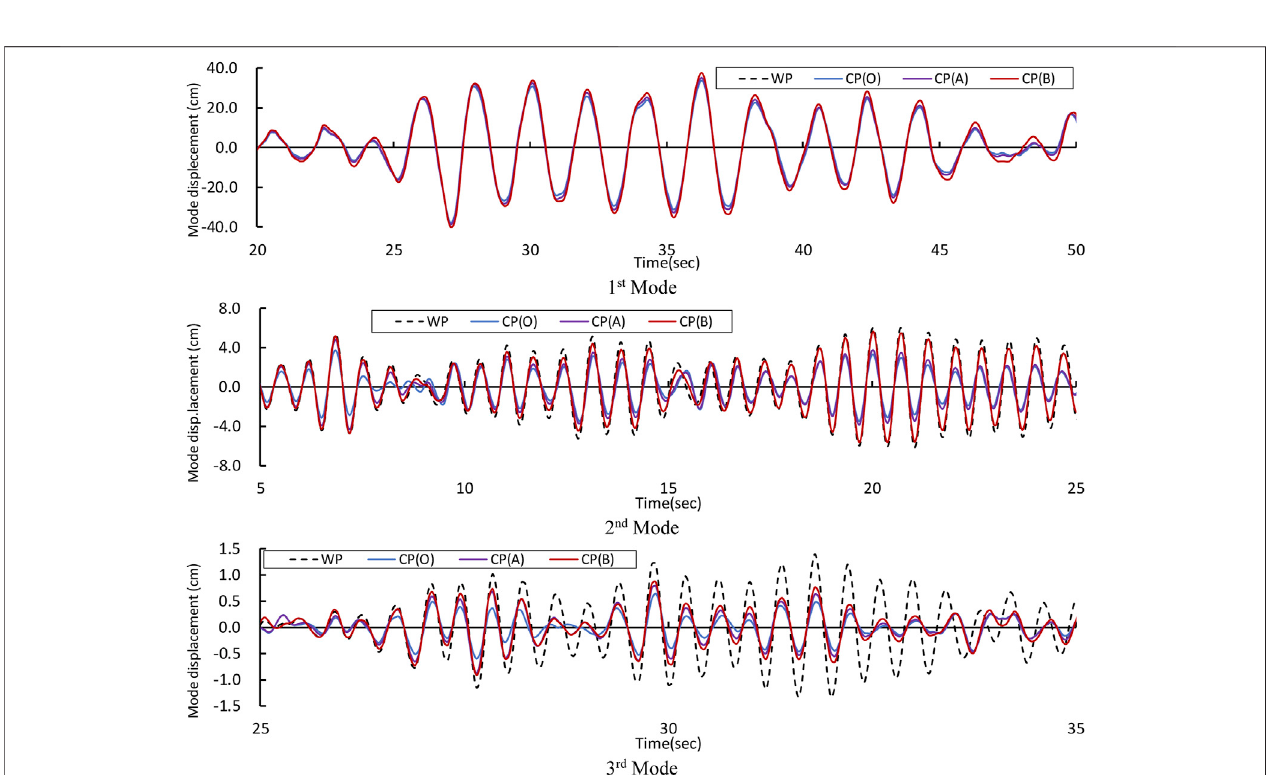
FIGURE 9 | Time histories of the modal